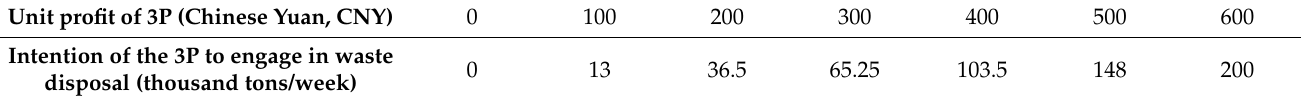
Table 3. Intention of the 3P to engage in waste disposal in different unit profits.